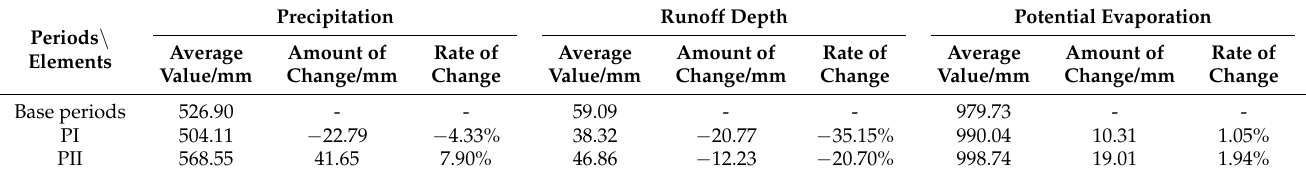
Table 4. Changes in hydrometeorological elements in the Weihe River basin in different